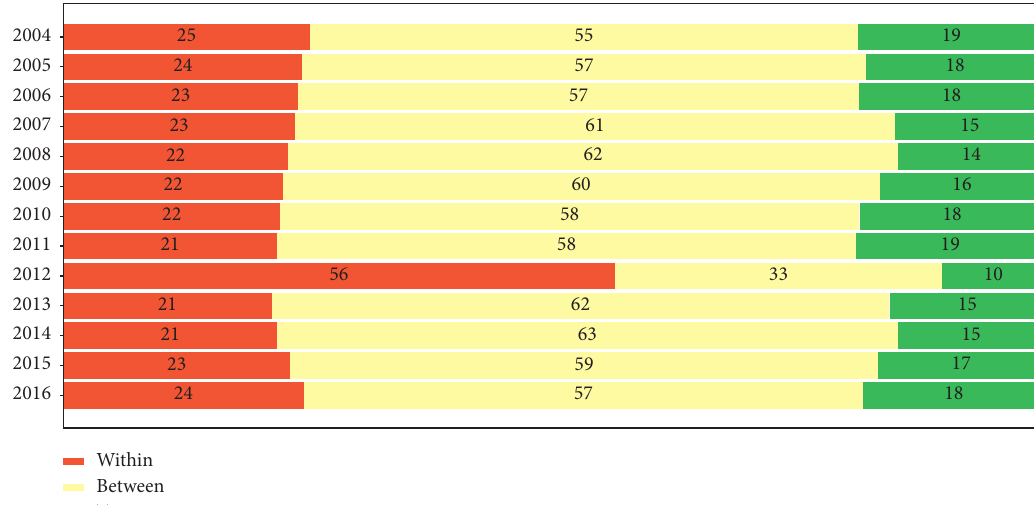
Figure 4: Gini coefficient and decomposition of urban construction land utilization efficiency.